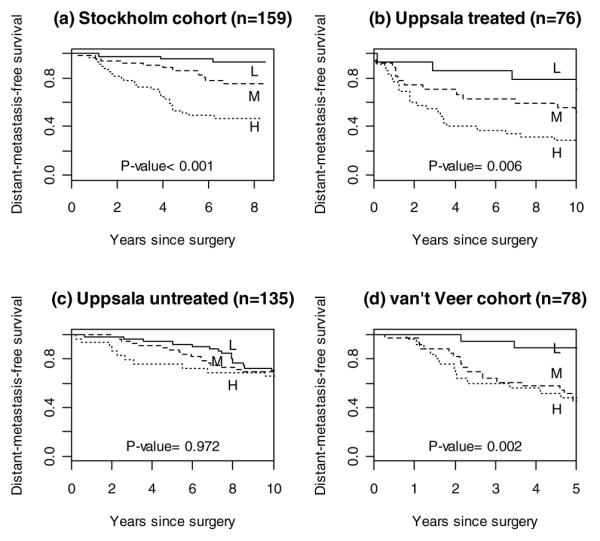
Kaplan–Meier survival curves of the risk clusters found in (a) the Stockholm cohort, (b) the Uppsala treated cohort, (c) the Uppsala untreated cohort and (d) the van't Veer cohort. L, low-risk group; M, medium-risk group; H, high-risk group. The P value in each plot, computed in a Cox regression, is for simultaneous comparison of all three curves for the whole follow-up period.